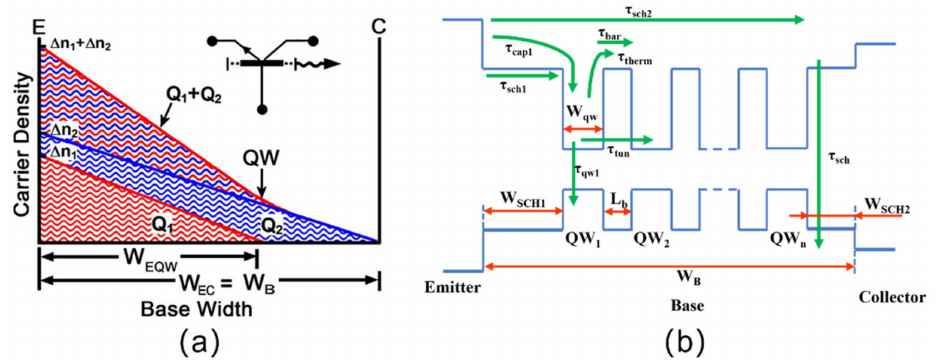
Figure 4. ( a ) Carrier density model of the base region; the triangular distribution of Q1 and Q2 corresponds to the capture of carriers by QW and the transition of the base region [24]. ( b ) Simplified TL carrier transport model for any number of